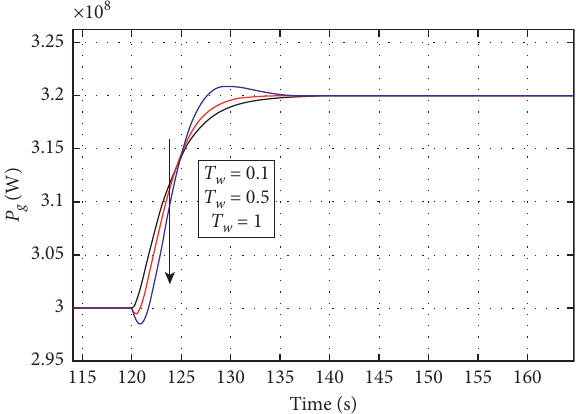
w on the output power of